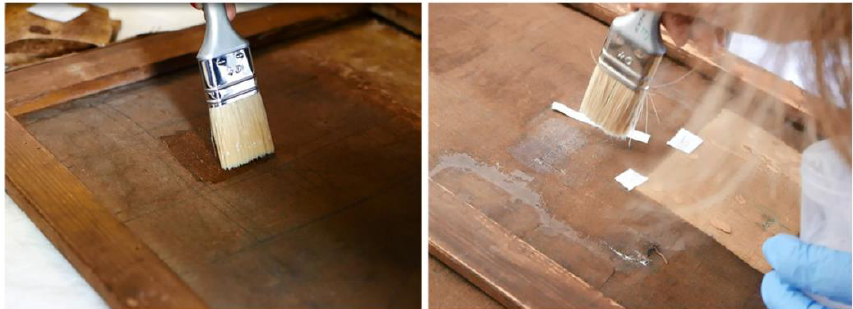
Figure 6. Application of nanocomposite consolidants on original paintings. Reproduced under terms of the CC-BY license [24]. Copyright © 2020, The Authors, published by Springer Nature.